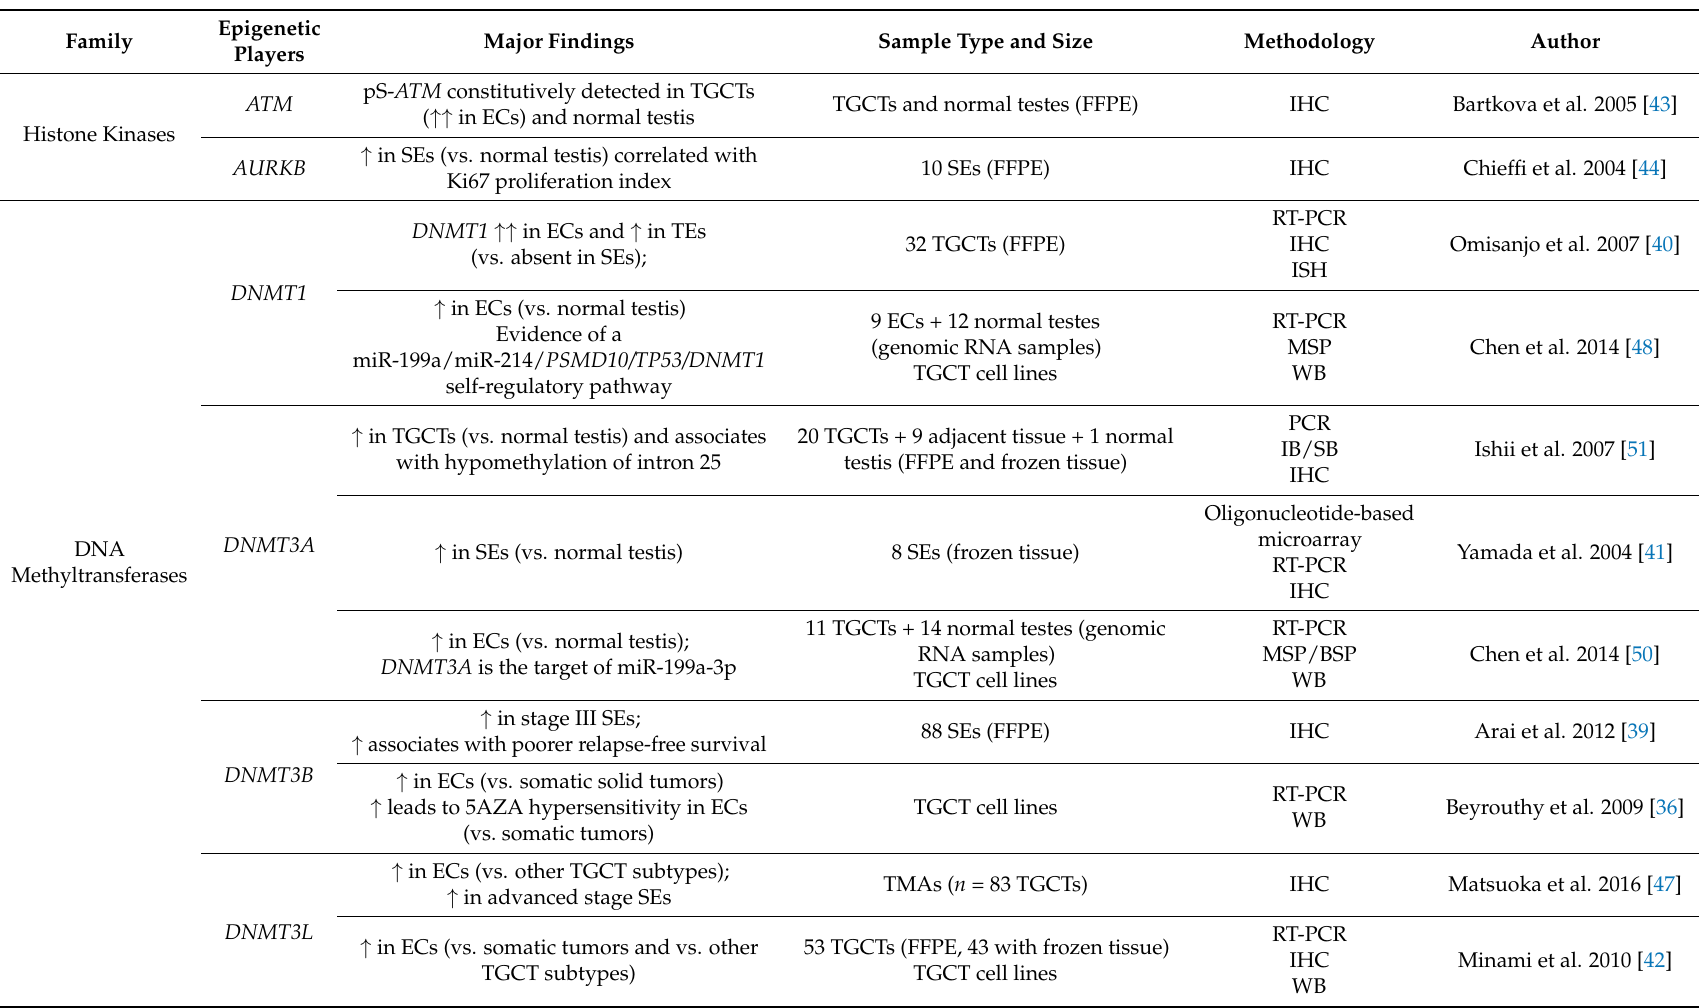
Table 1. Summary of most relevant publications regarding the role of DNA/histone-modifying enzymes and chromatin remodeling complexes involved in testicular germ cell